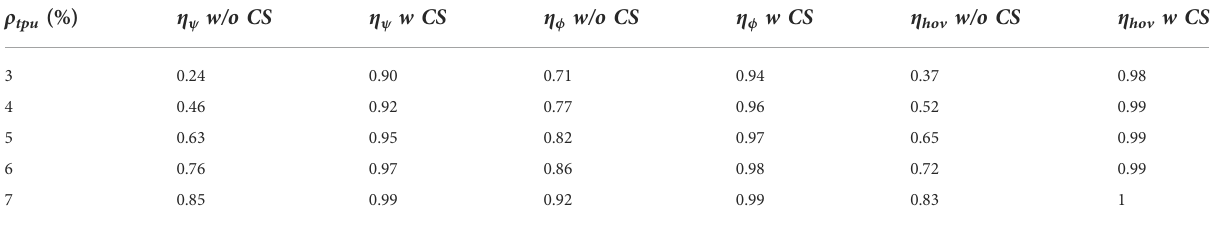
TABLE 4 Comparison of the ef fi ciencies of the fl exible UAV when introducing the compensation system CS (triangles) for hovering η hov (blue curves), roll η ϕ (green curves), and yaw η ψ (red curves) maneuvers. ρ (%) η ψ w/o CS tpu